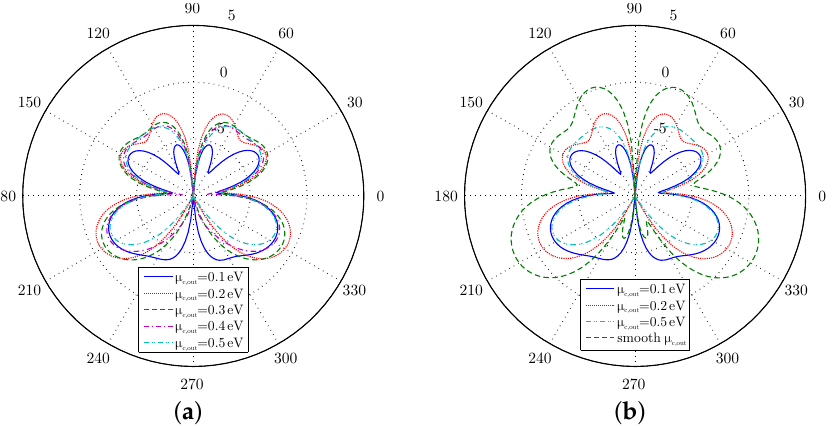
Figure 9. Radiation pattern at xy − plane ( a ) for different chemical potential constant values of the matching component and ( b ) including a step-like matching